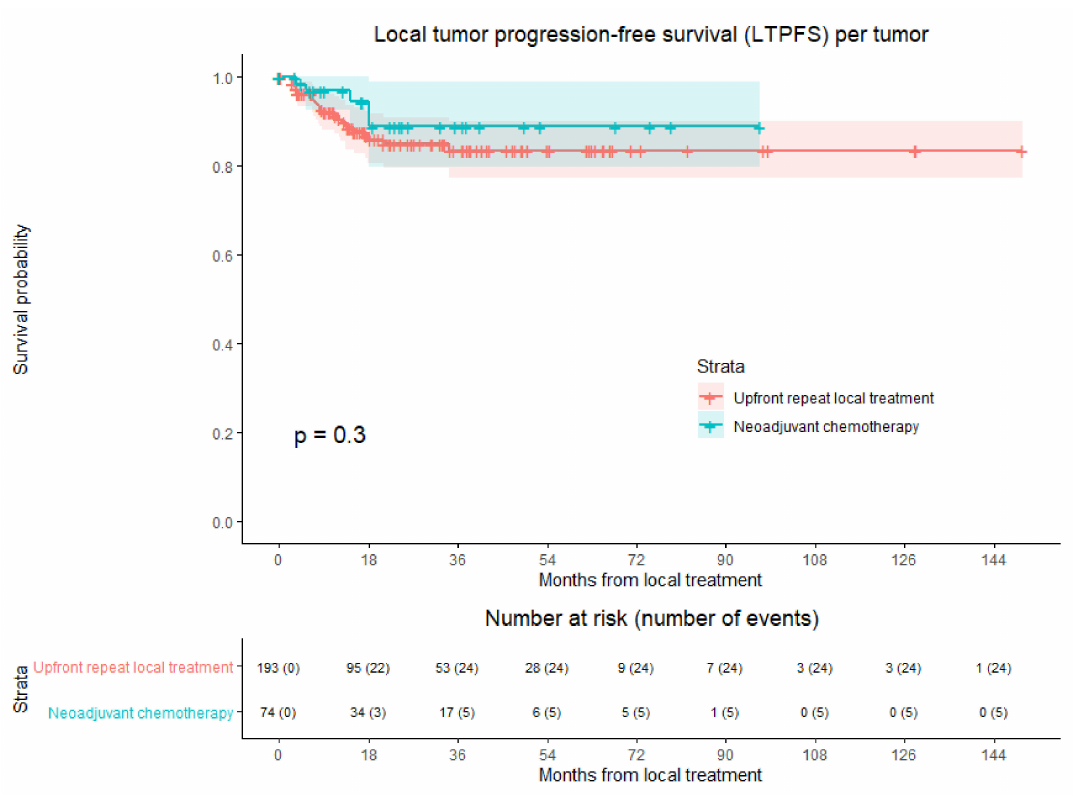
Figure 2. Kaplan–Meier curves of local tumor progression-free survival (LTPFS) per tumor after upfront repeat local treatment (red) and neoadjuvant chemotherapy followed by repeat local treatment (green). Numbers at risk (number of events) are per tumor. Overall comparison log-rank (Mantel–Cox) test, p = 0.300. Death without local tumor progression (LTP; competing risk) is